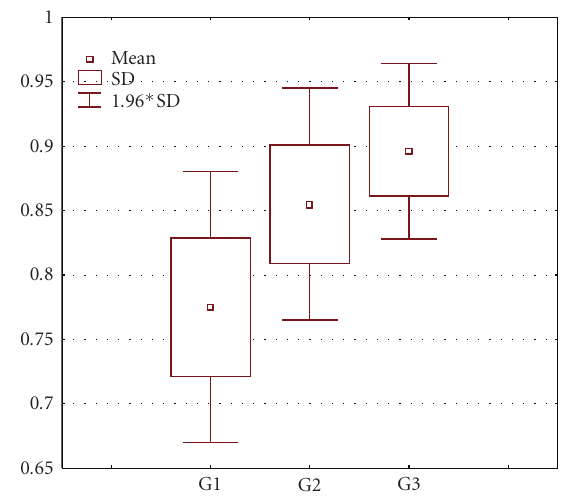
Figure 9: Posthoc test results of the least significant di ff erences, LSD, between di ff erent groups of cancer with regard to grading (axis X-groups, axis Y-fractions of stained